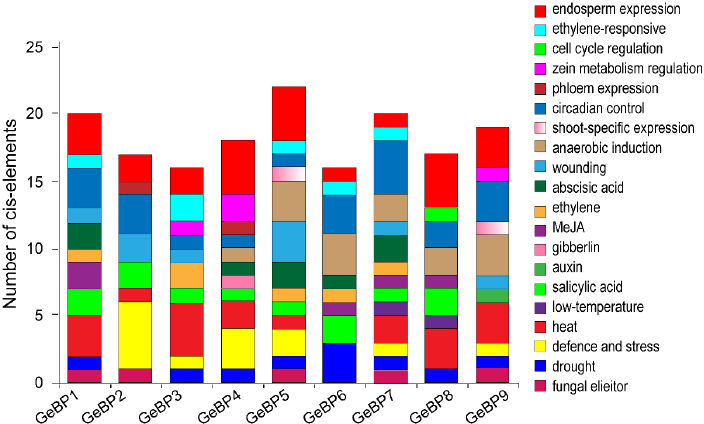
Figure 3. Cis-elements in the promoters of putative GmGeBP genes. Different cis-elements with the same or similar functions are present with the same